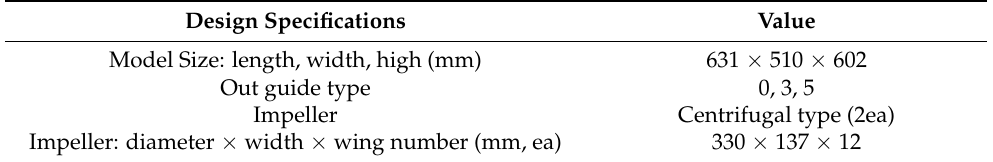
Figure 4. Schematic diagram showing boundary conditions and internal flow field of blowing fan for analysis model. Table 4. Specifications of the blowing fan